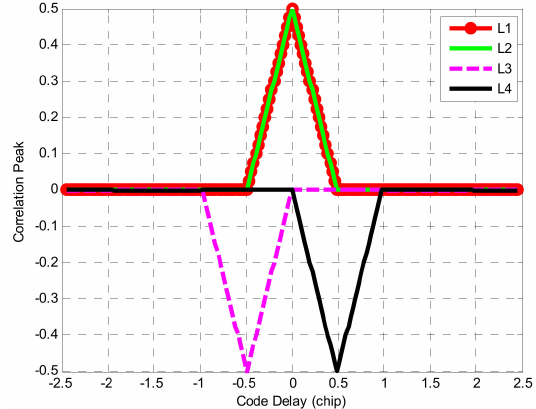
Figure 3. Composition of BOCs(1,1) signal autocorrelation